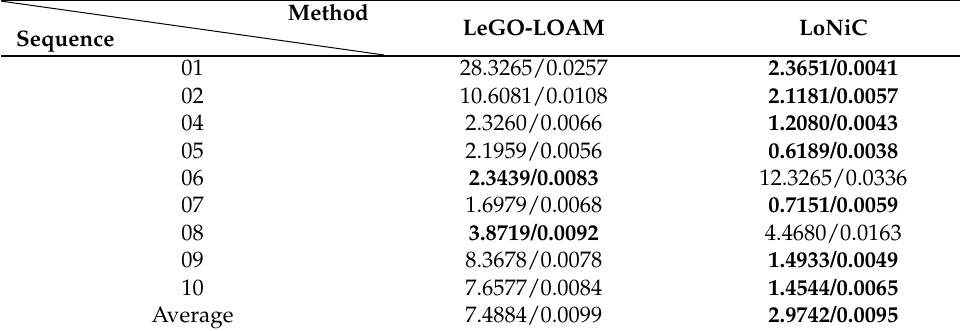
Table 4. Relative pose error of LeGO-LOAM and LONIC on the KITTI dataset.